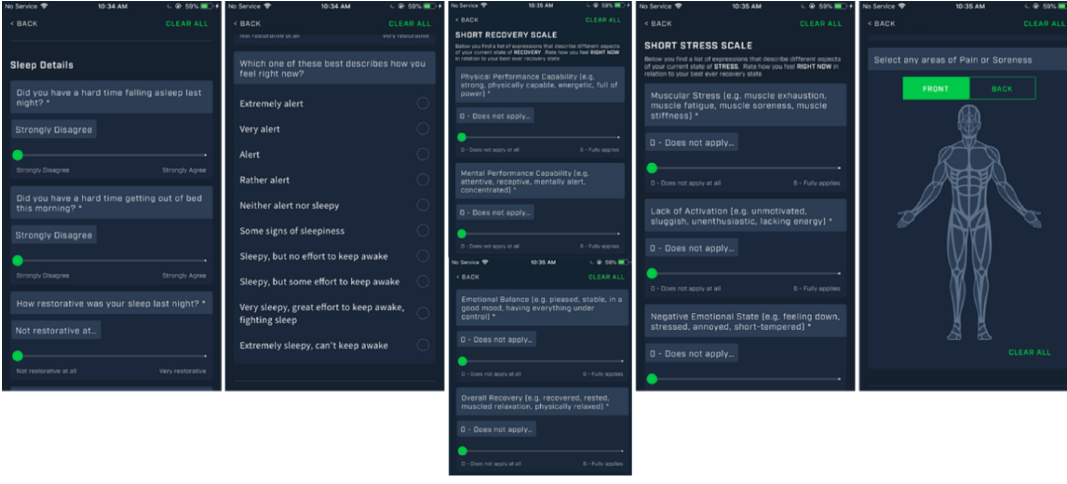
Figure 3. Athlete Health/Wellness Daily Questions.